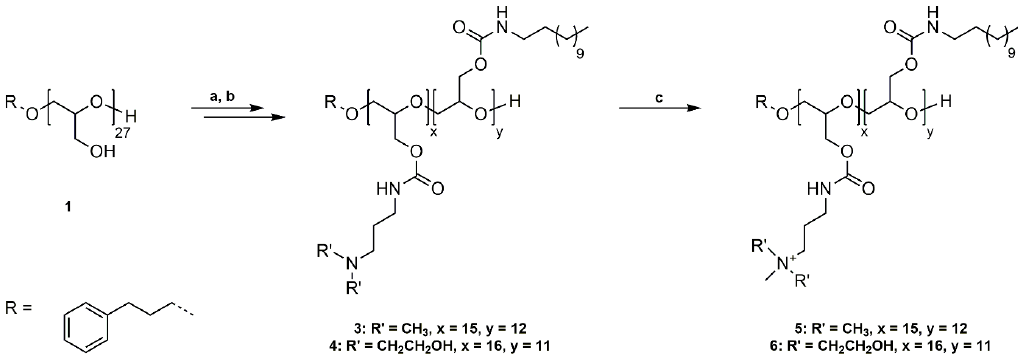
Figure 2. 1 H NMR spectra of P(G TMAPA15 - co -G DDA12 ) ( 5 ) measured in DMSO- d 6 ( a ) and P(G APDEMA16 - co - G DDA11 ) ( 6 ) measured in MeOD ( b